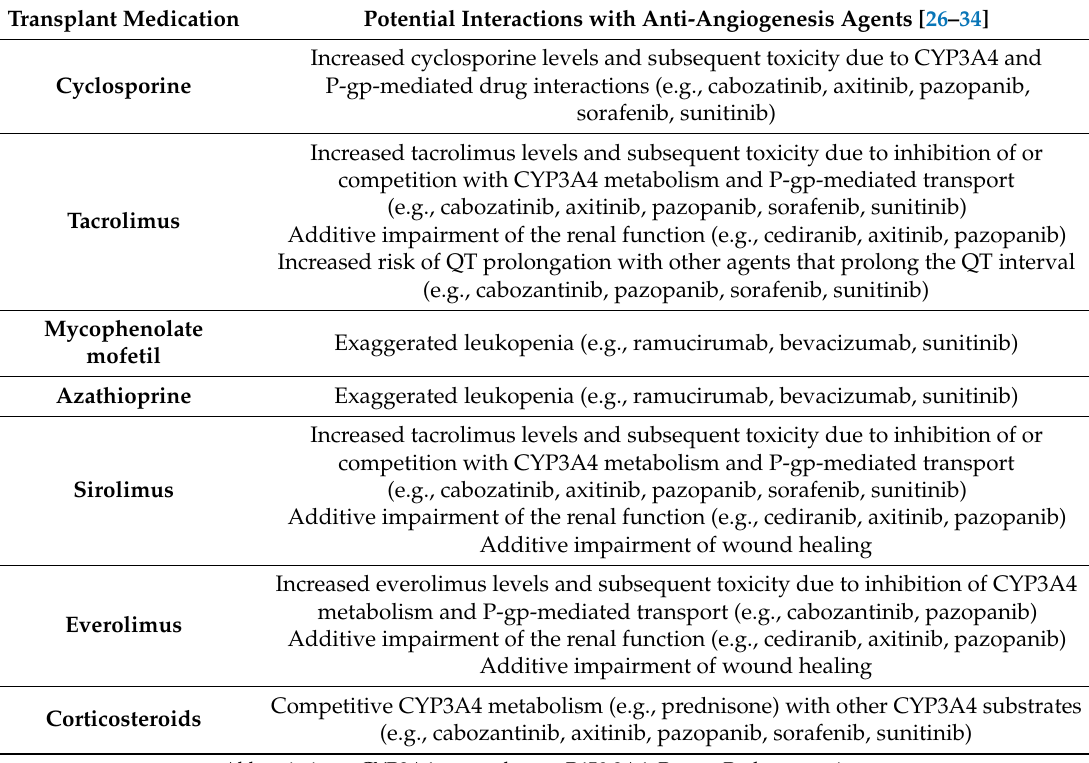
Table 2. Drug–drug interactions between post-transplant immunosuppressive medications and angiogenesis